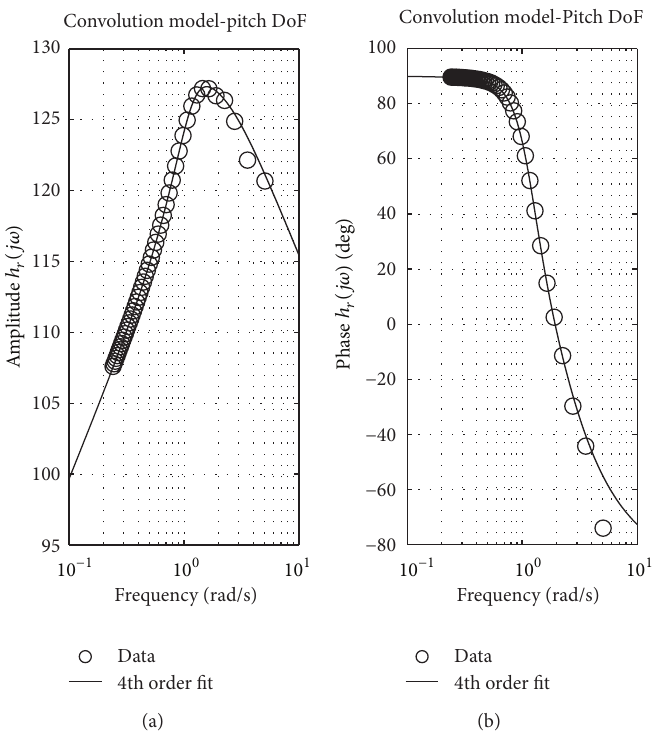
Figure 2: Frequency domain identification for the ISWEC floater: 4th order transfer function magnitude and phase.